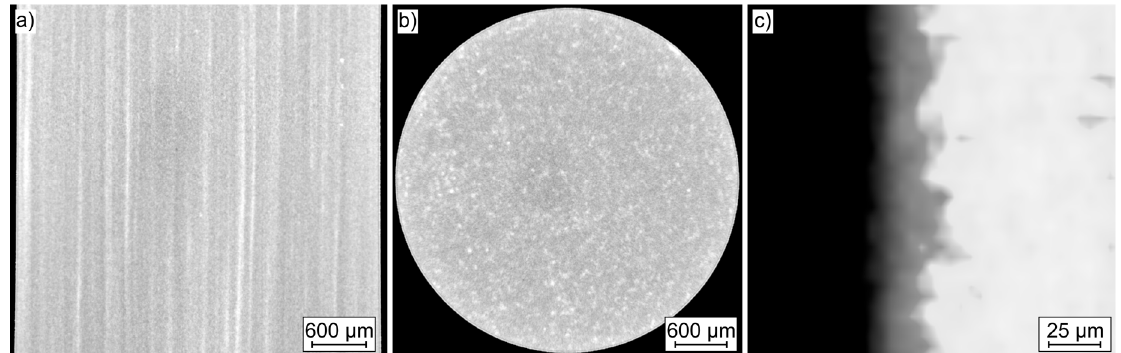
Figure 1. µ -Computed tomography images of cylindrical specimens: ( a ) longitudinal section of Mg WE43 MEO specimen, ( b ) cross section of Mg WE43 MEO specimen, ( c ) longitudinal section of Mg WE43 MEO plasma electrolytic oxidation (PEO) layer.